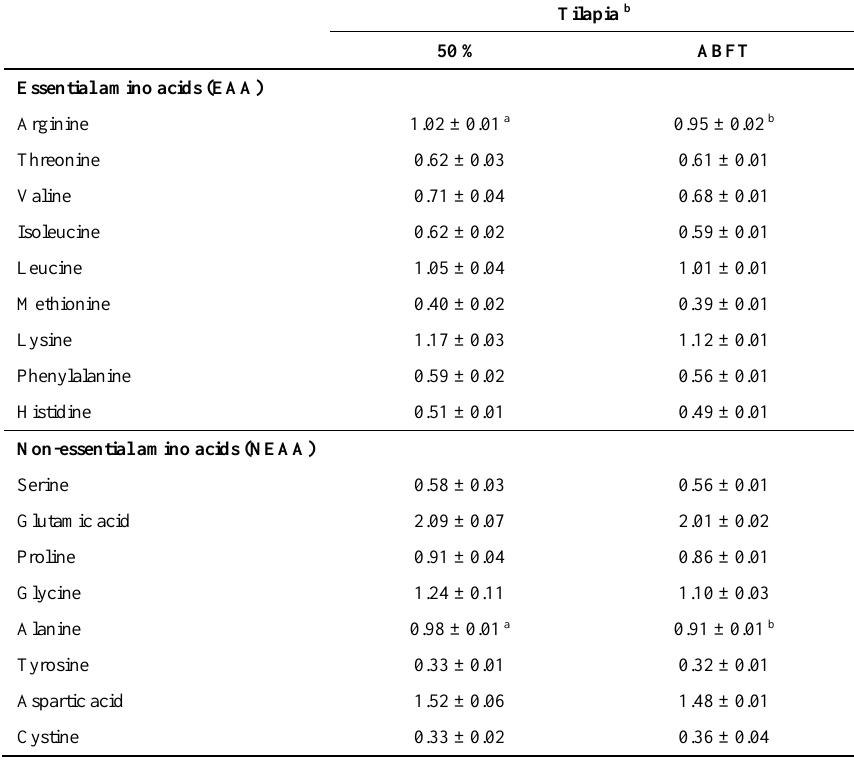
a Values are means from triplicate groups of fish where the values in each row with different superscripts are significantly different ( P < 0.05) b Wet weight